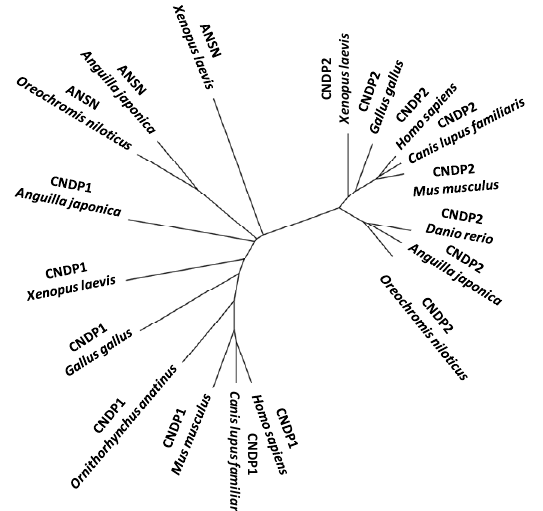
Figure 5. An unrooted phylogenetic tree of CNDP1, ANSN, and CNDP2 of M20A peptidase genes of